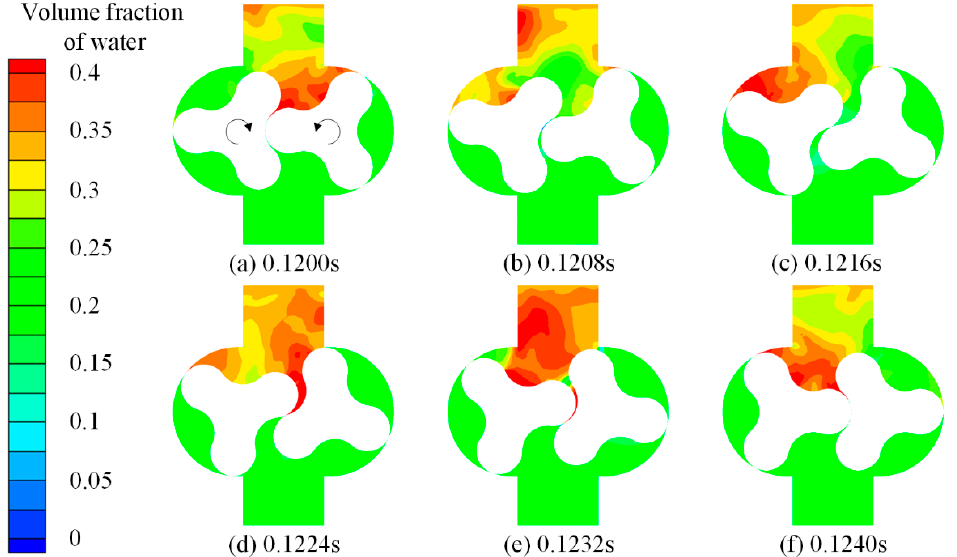
Figure 7. Water volume fraction contours of the Roots pump when the inlet CO 2 volume fraction is 0.8. Flow time: ( a ) 0.1200s; ( b ) 0.1208s; ( c ) 0.1216s; ( d ) 0.1224s; ( e ) 0.1232s; ( f ) 0.1240s.